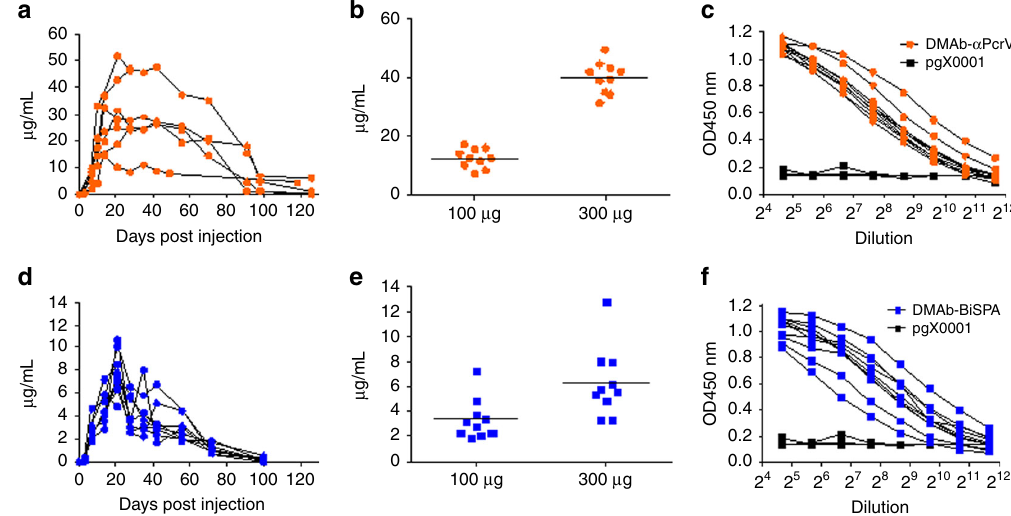
Fig. 3 In vivo expression of DMAb- α PcrV and DMAb-BiSPA in mice. a B6.Cg-Foxn1 < nu > /J mice ( n = 5/group) were administered 100 µ g of DMAb- α PcrV by IM-EP. Serum levels of human IgG were monitored over 120 days. b Day 7 serum levels in BALB/c mice ( n = 10/group) administered 100 and 300 µ g for DMAb- α PcrV. The line represents the mean value. c Day 7 serum binding to PcrV protein in BALB/c mice ( n = 10/group) administered 100 µ g of DMAb- α PcrV. d B6.Cg-Foxn1 < nu > /J mice ( n = 5/group) were administered 100 µ g of DMAb-BiSPA by IM-EP. Serum levels of human IgG were monitored over 120 days. e , b Day 7 serum levels in BALB/c mice ( n = 10/group) administered 100 and 300 µ g for DMAb-BiSPA. The line represents the mean value. f Day 7 serum binding to PcrV protein in BALB/c mice ( n = 10/group) administered 100 µ g of DMAb-BiSPA